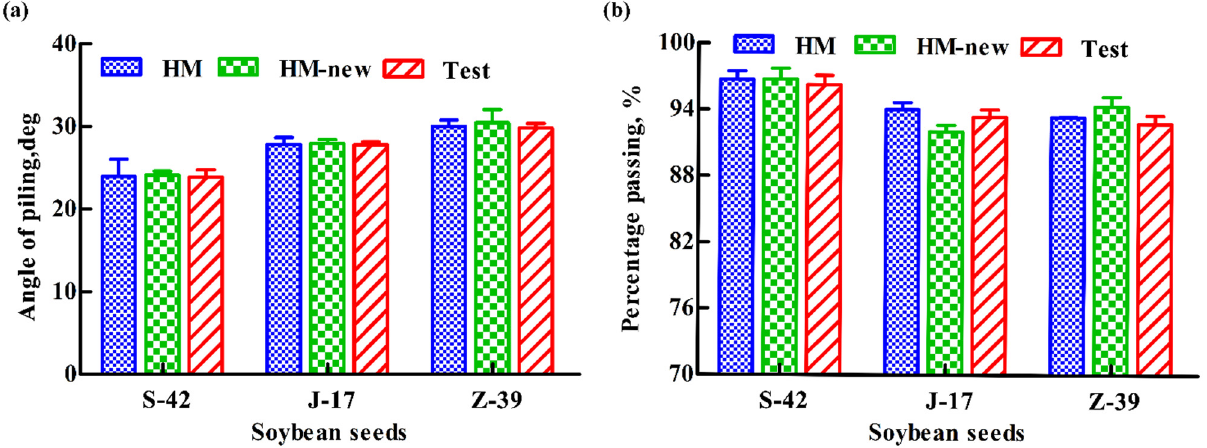
Figure 23. Comparisons of the test results with the simulation results using the Hertz-Mindlin (no-slip) (HM) and HM-new-restitution (HM-new) models for the simulations of ( a ) “piling angle” and ( b ) “self-flow screening”.